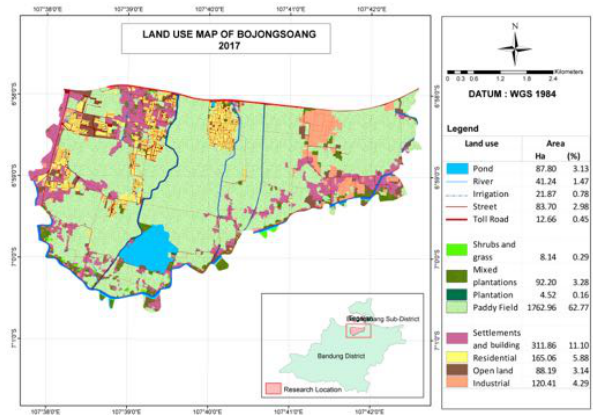
Figure 1. Land use map of Bojongsoang created by Bogor Agricultural University (IPB). Flooded area observed by satellite(Feb.21 to Mar.4, 2018) PLANET observations in Bojongsoang (False color images)